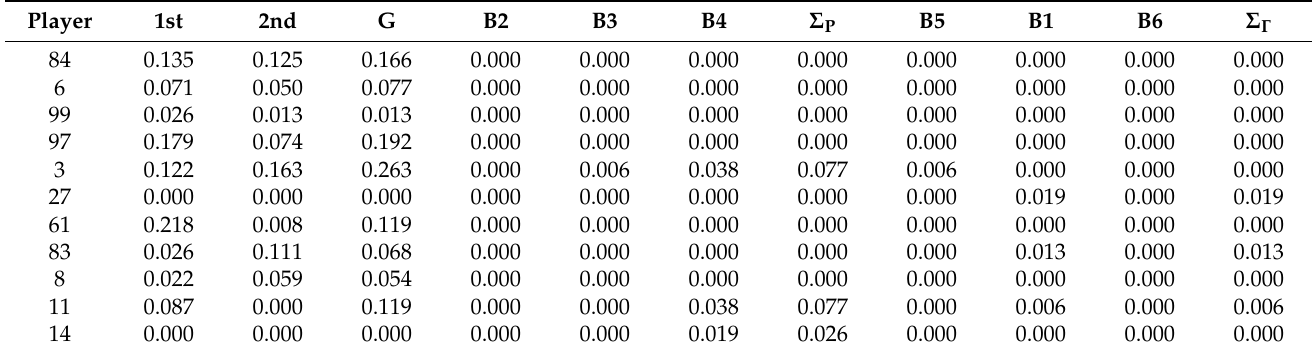
Table A5. Team A’s Betweenness Centrality Matrix of values.